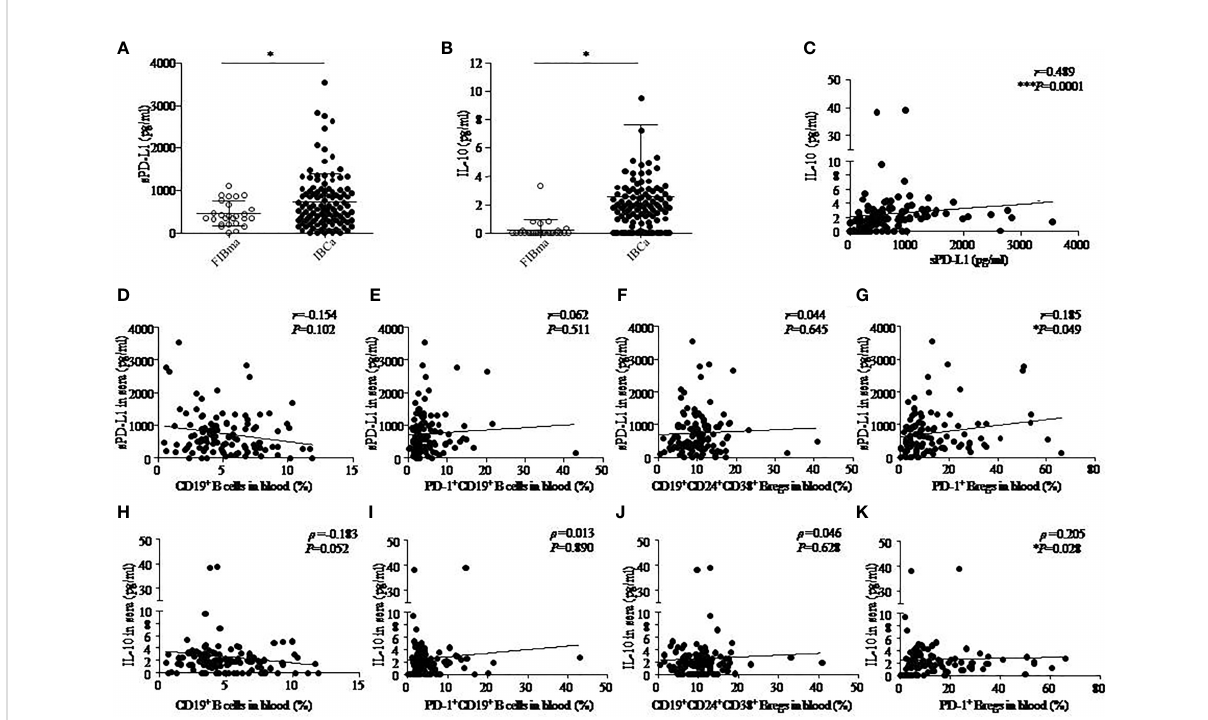
FIGURE 2 The correlation among IL-10, sPD-L1, and CD19 + B-cell subsets in IBCa. The production of soluble programmed death ligand 1 (sPD-L1) and interleukin-10 (IL-10) in the sera of FIBma (N = 26) and IBCa patients (N = 114) was measured by enzyme-linked immunosorbent assay (ELISA), as described in “ Materials and methods ” . The correlations between sPD-L1 and IL-10, sPD-L1 and CD19 + B-cell subsets, and also IL-10 and CD19 + B-cell subsets in IBCa patients (N=114) were investigated. sPD-L1 levels in the sera of IBCa patients and FIBma patients (A) . IL-10 levels in the sera of IBCa patients and FIBma patients (B) . The correlation between the levels of IL-10 and sPD-L1 in the sera from IBCa patients ***P = 0.0001 (C) . The correlation between the abundance of CD19 + B cells and sPD-L1 in the sera from IBCa (D) . The correlation between the abundance of PD-1 + CD19 + B cells and sPD-L1 in the sera from IBCa (E) . The correlation between the abundance of CD19 + CD24 + CD38 + Bregs and sPD-L1 in the sera from IBCa (F) . The correlation between the abundance of PD-1 + CD19 + CD24 + CD38 + Bregs and sPD-L1 in the sera from IBCa (G) . The correlation between the abundance of CD19 + B cells and IL-10 in the sera from IBCa (H) . The correlation between the abundance of PD-1 + CD19 + B cells and IL-10 in the sera from IBCa (I) . The correlation between the abundance of CD19 + CD24 + CD38 + Bregs and IL-10 in the sera from IBCa (J) . The correlation between the abundance of PD-1 + CD19 + CD24 + CD38 + Bregs and IL-10 in the sera from IBCa (K) . Each dot represents an individual patient. All values show the means ± SEM. Data were analyzed by unpaired Student ’ s t -test (A-B), Pearson ’ s correlation (C-G), and Spearman ’ s correlation (H-K). ns, not statistically signi fi cant, * P < 0.05 and *** P <